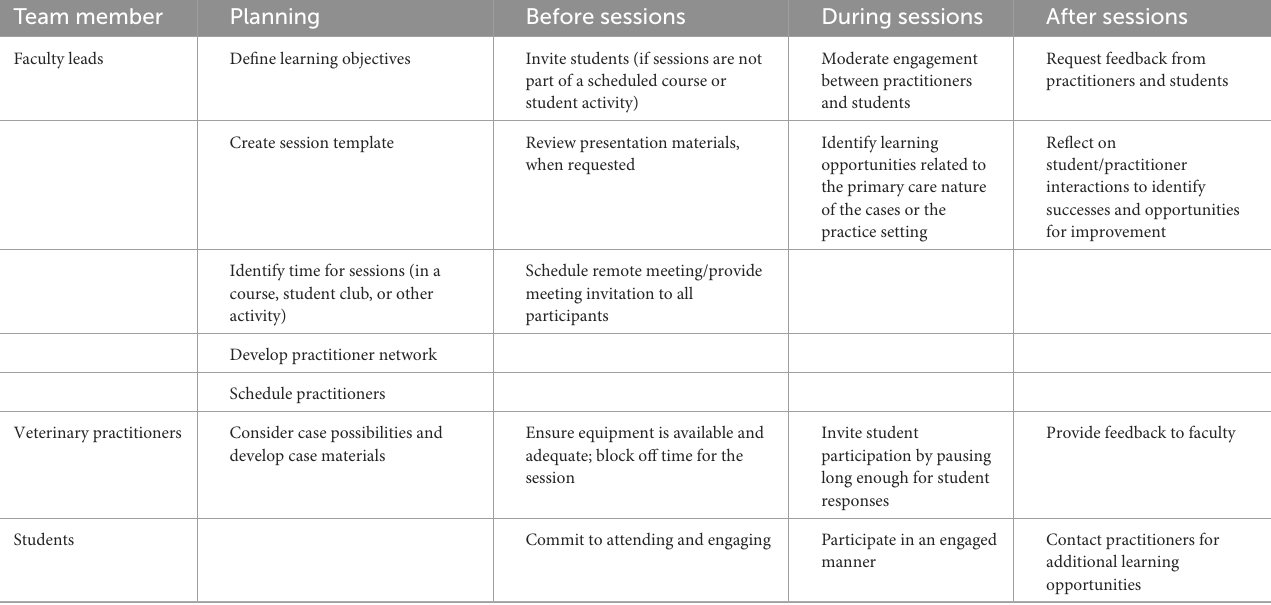
TABLE 2 Activity recommendations for teaching faculty, veterinary practitioners and students during planning and conduct phases of telehealth case discussions using a remote platform. Team